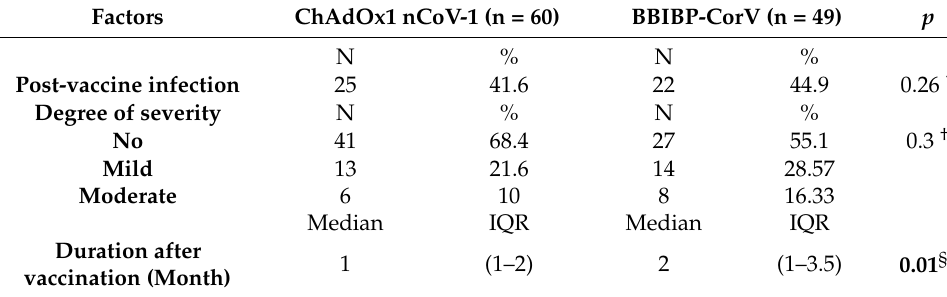
Table 6. Short-term protective effects of